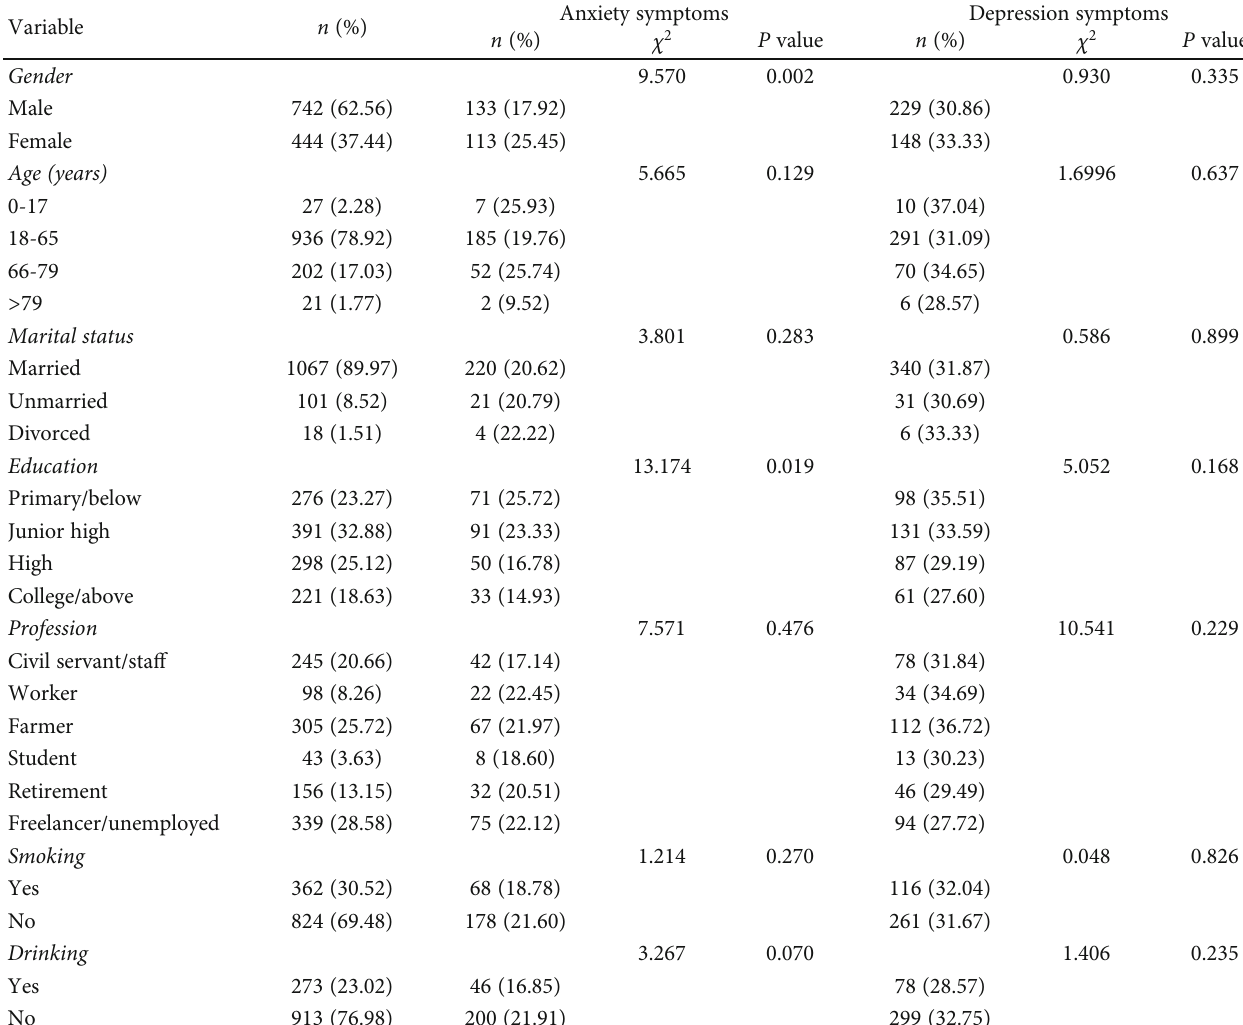
Table 2: Detection rates of anxiety and depression symptoms in participants with di ff erent demographic characteristics.